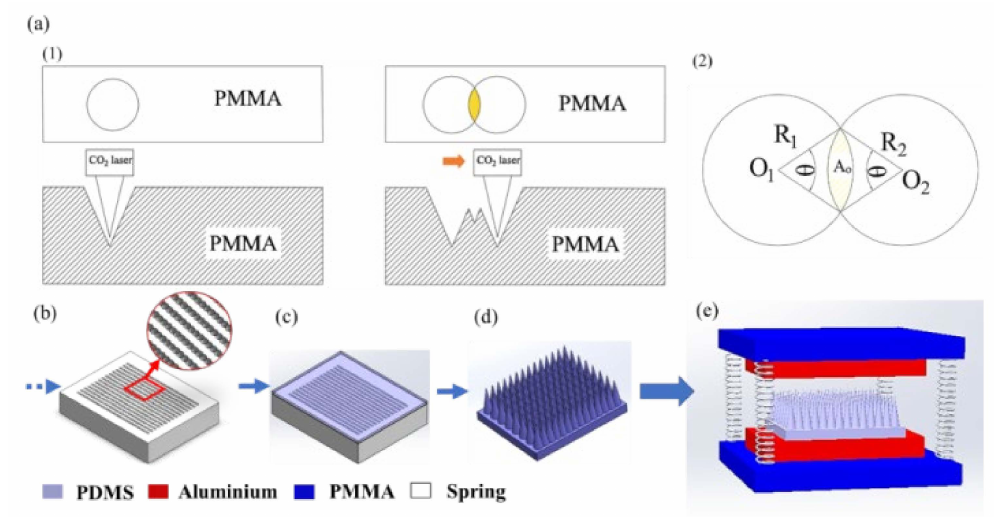
Figure 29. Schematic overlapped two-height microneedle PDMS fabrication and assembly: ( a1 ) CO 2 laser ablated PMMA master mold of two-height holes consisting of a primary height in the laser spot and an extra second-height in the overlapped area; ( a2 ) estimation of the overlapped area ratio; ( b – e ) Experiment process of PDMS film and the OL-DTH-MN-TENG assembly diagram. The OM micrographs of the PMMA master mold (top three) and corresponding cast PDMS microneedles (bottom three) of OL-MN, OL-TH-MN, and OL-DTH-MN, respec- tively, are shown in Figure 30a. The pattern density of OL-MN is 654 MN cm − 2 while the higher density of OL-TH-MN and OL-DTH-MN are 965 MN cm − 2 , which is 1.4 times higher than OL-MN. The surface contact area of OL-MN, OL-TH-MN, and OL-DTH-MN is estimated by 3D parametric Solidworks software. The proper overlapped two-height microneedle array highly enhances the contact surface area of the complex deep two-height microneedles array. Moreover, Figure 30b shows that the overlapped area height of the OL-TH-MN and OL-DTH-MN has two kinds of height for microneedles, that is, the over- lapped conical tips area above the overlapped bottom area denoted as primary-height HT 1 and secondary-height HT 2 , and the other is the total height (H) and width (W) of single microneedle including the non-overlapped and overlapped area. The magnitude of H and W of MN is OL-MN > OL-TH-MN but the pattern density of OL-TH-MN (965 MN/cm 2 ) is 1.47 times OL-MN (654 MN/cm 2 ) due to the contributed laser energy per spot that de- creases at shorter ablation spacing. The H and W of OL-DTH-MN is the highest of a single MN due to the increased laser power. The calculated total effective surface area order is OL-DTH-MN (29.69 × 103 mm 2 ) > OL-TH-MN (24.38 × 103 mm 2 ) > OL-MN (22.91 × 103 mm 2 ). It is noted that the OL-DTH-MN enhances the MN height and width to promote the total contact surface